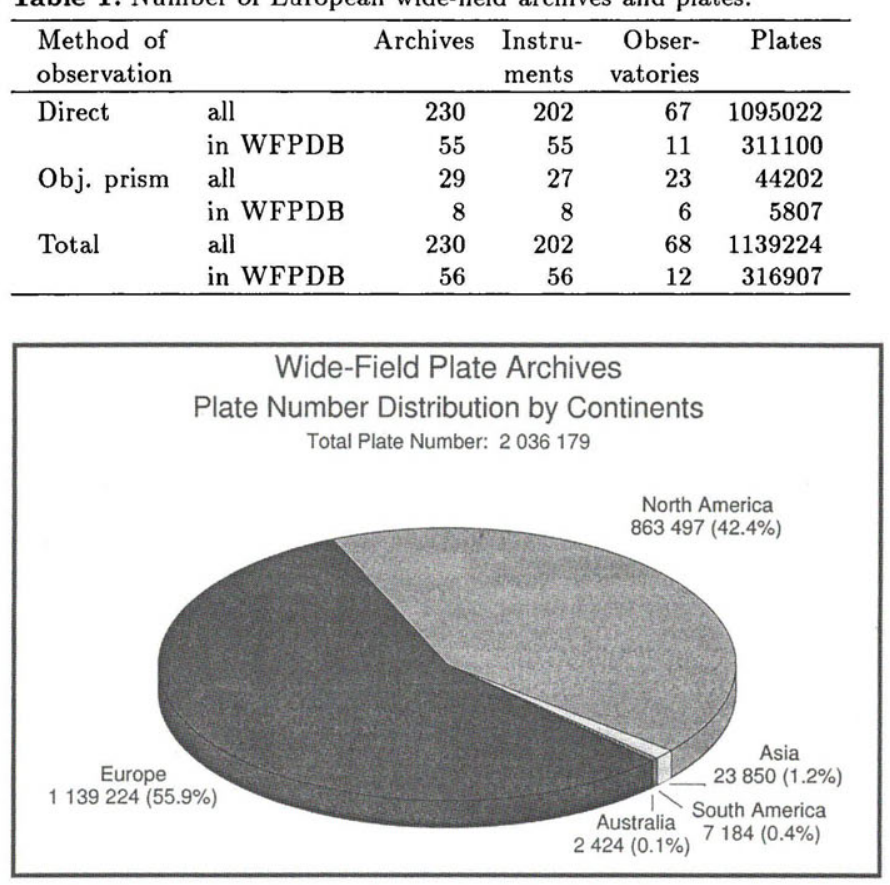
Table 1. Number of European wide-field archives and plates.